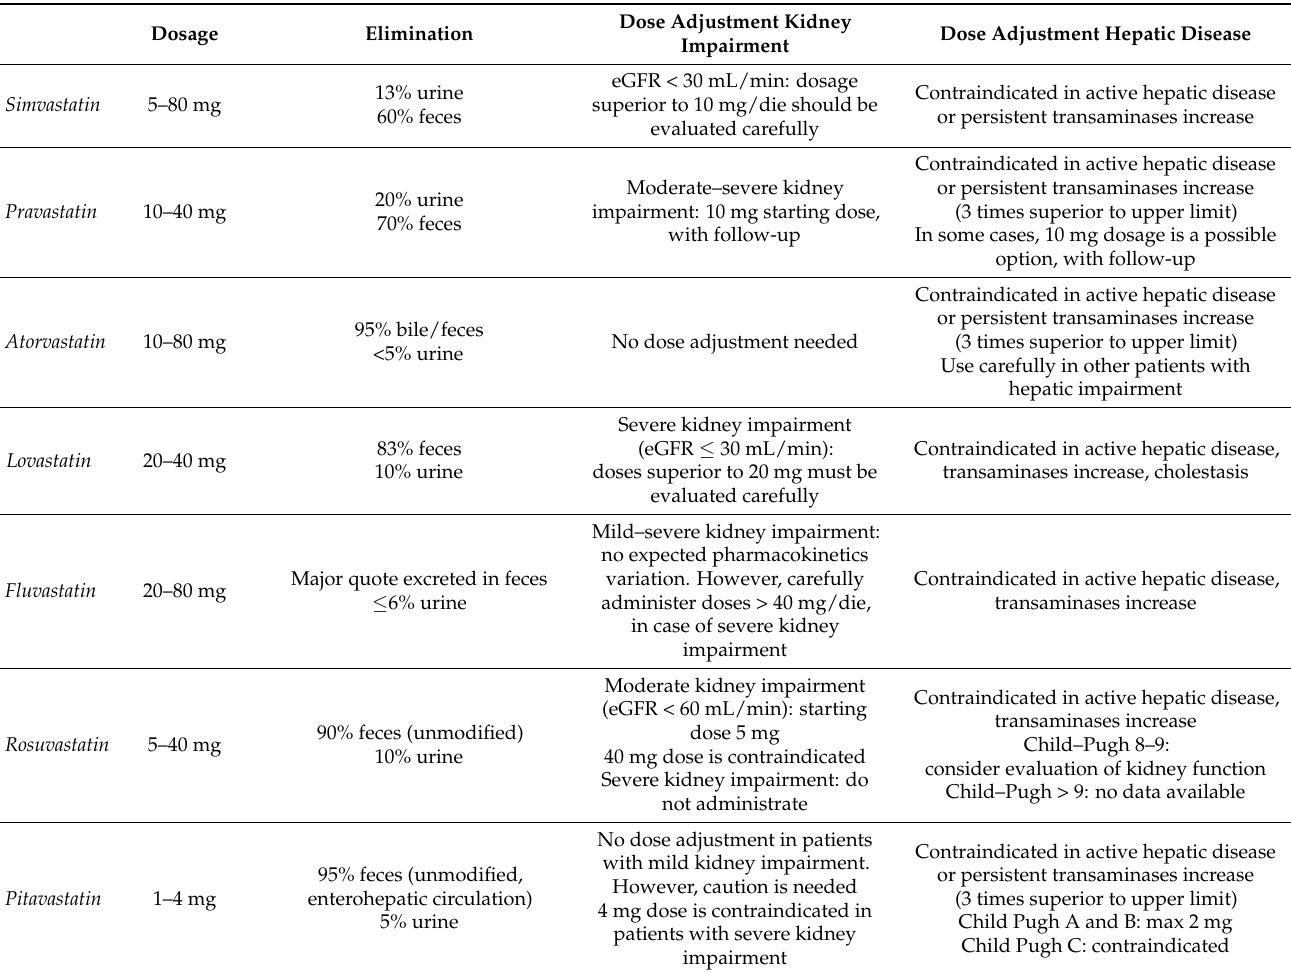
Table 2. Statins excretion and dose